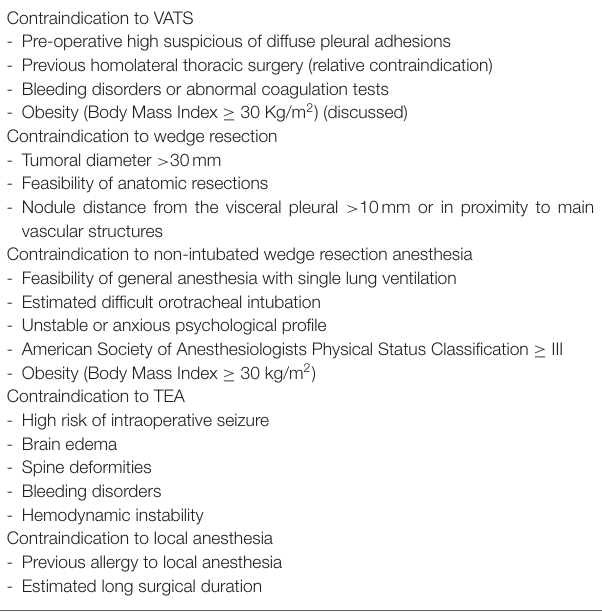
TABLE 2 | General contraindication to non-intubated wedge resection for peripheral pulmonary